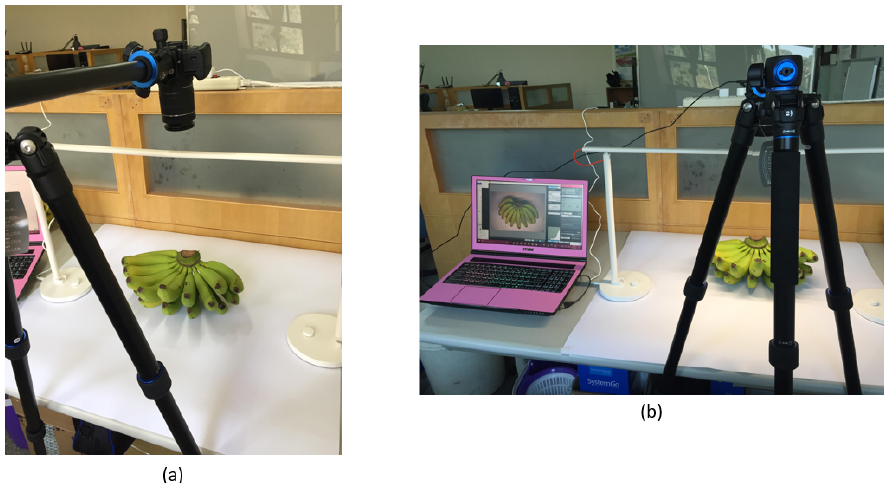
Figure 1. Experimental setup for obtaining RGB images of bananas, ( a ) white background with constant camera height, and ( b ) capture and image resizing software.